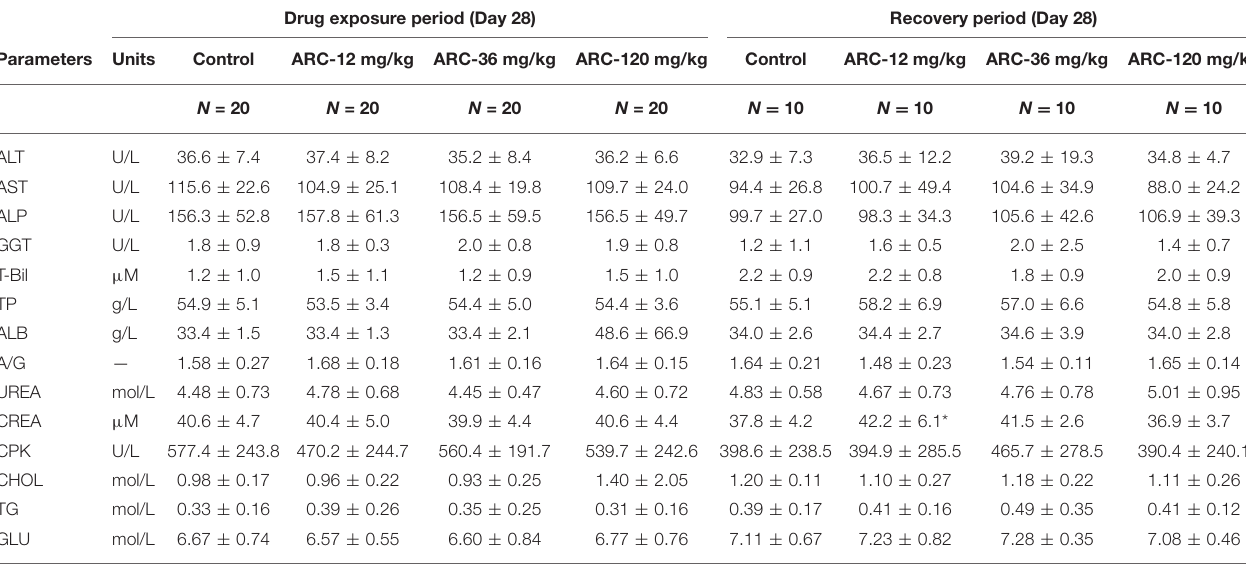
TABLE 3 | The biochemical examination paremeters of Arctigenin (12-, 36-, and 120 mg/kg) administration by gavage (i.g) in rats’ serum at the end of drug exposure period and recovery period ( n = 10, 5 female, 5 male per treatment group, results were presented as Mean ±